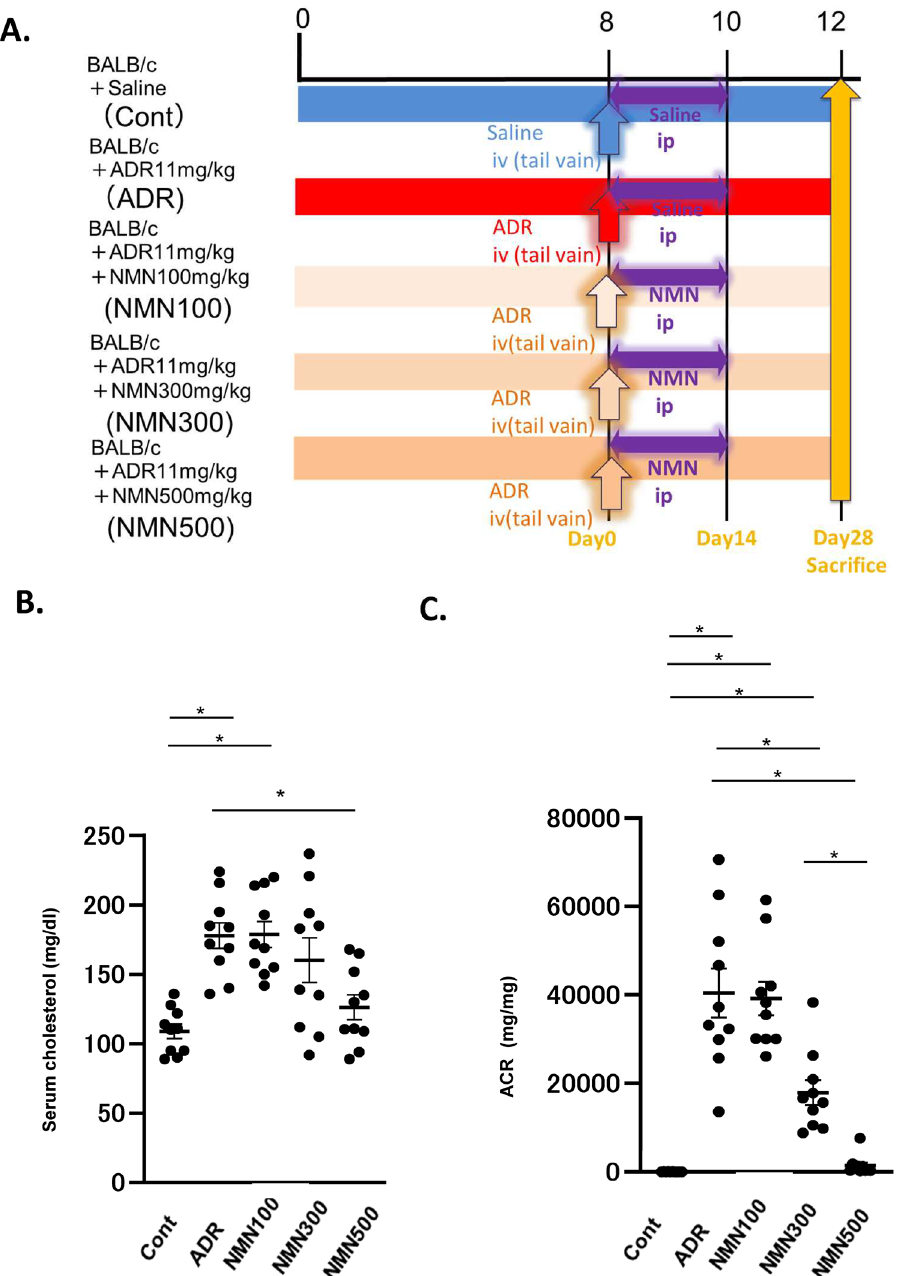
Figure 3. Dose–response study of NMN treatment. ( A ) Schematic diagram illustrating the dose–response study. ( B ) Cholesterol levels on day 28 in the five groups (Cont, ADR , NMN100, NMN300, and NMN500; n = 15). Statistical significance is represented by an asterisk. * P < 0.05 vs Cont . ( C ) Urine ACR on day 28 in the five groups ( Cont , ADR , NMN100, NMN300, and NMN500; n = 15). All data are shown as mean ± standard error of the mean. Statistical significance between each group is represented by a horizontal bar. * P <